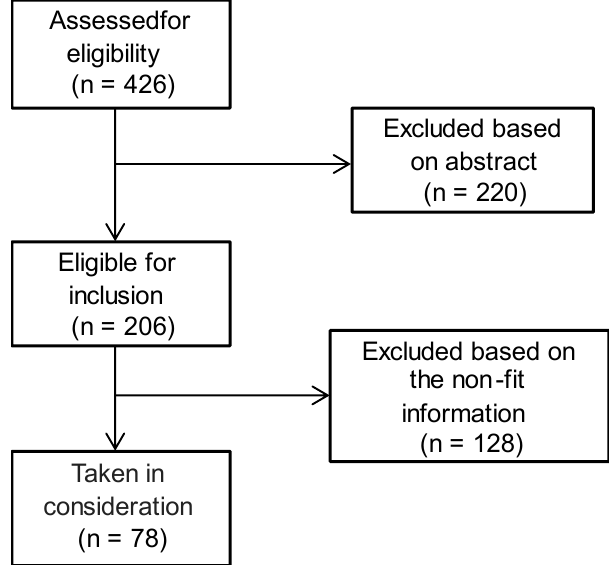
Figure 3. Consort diagram of the literature research.